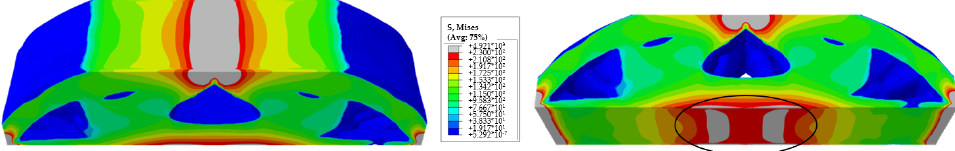
Figure 25. Results of the static FE analysis for the derived design proposal of the developed optimiza- tion method under the boundary conditions of optimization case 2.